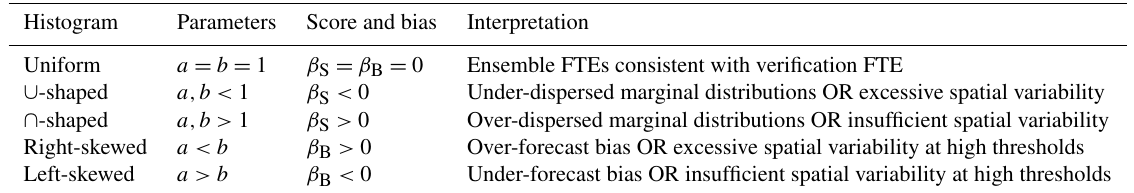
Table 1. Characterization of FTE histogram shapes via β -score and β -bias and their interpretation with regard to potential deficiencies of the ensemble forecast fields. Histogram Parameters Score and bias Interpretation Uniform a = b = 1 β S = β B = 0 Ensemble FTEs consistent with verification FTE ∪ -shaped a,b < 1 β S < 0 Under-dispersed marginal distributions OR excessive spatial variability ∩ -shaped a,b > 1 β S > 0 Over-dispersed marginal distributions OR insufficient spatial variability Right-skewed a < b β B > 0 Over-forecast bias OR excessive spatial variability at high thresholds Left-skewed a > b β B < 0 Under-forecast bias OR insufficient spatial variability at high thresholds Skewness is exaggerated by high thresholds; see text for more